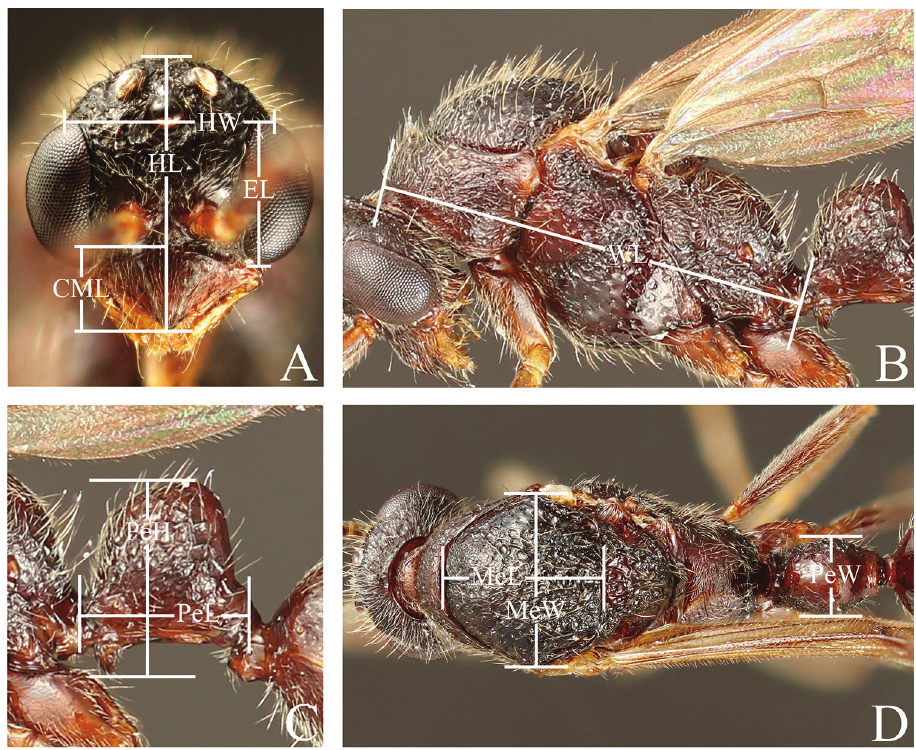
Figure 2. Measurements of male of the Leptogenys modiglianii species group. A Head, full-face view B lateral view C petiole, lateral view D dorsal view. HL Head length, HW Head width, CML Clypeal median lobe length, EL Eye length, MeL Mesoscutum length, MeW Mesoscutum width, WL Weber’s length, PeL Petiole length, PeH Petiole height, PeW Petiole width.